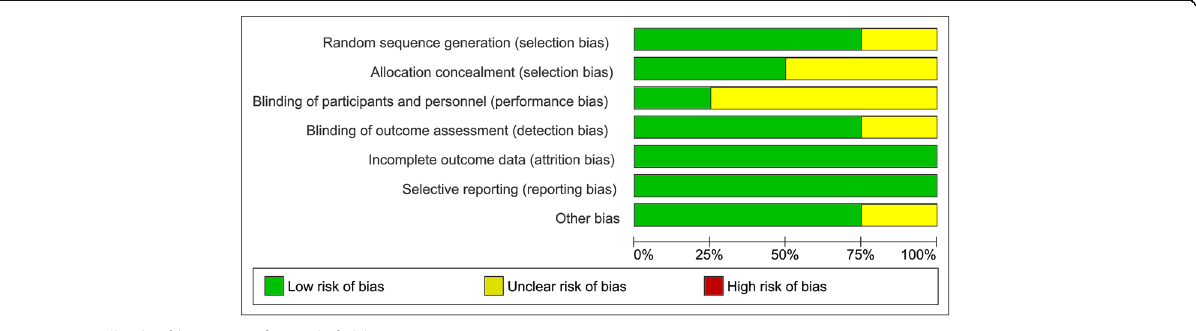
Fig. 3 Overall risk of bias score for each